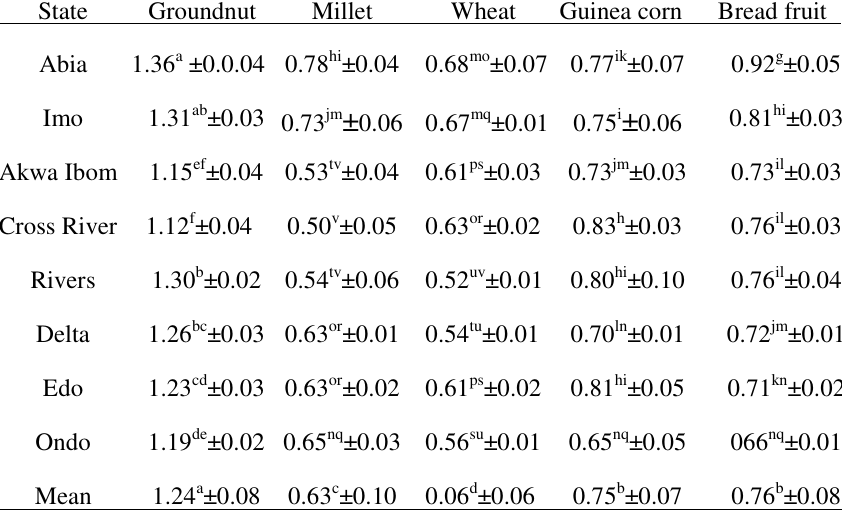
Table 1. Alkaloid content of grains, (%).